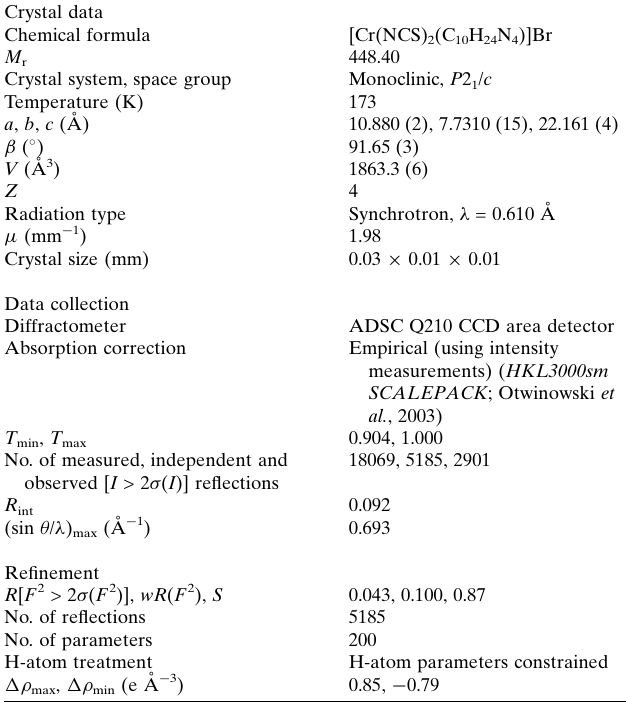
Table 2 Experimental details. Crystal data Chemical formula